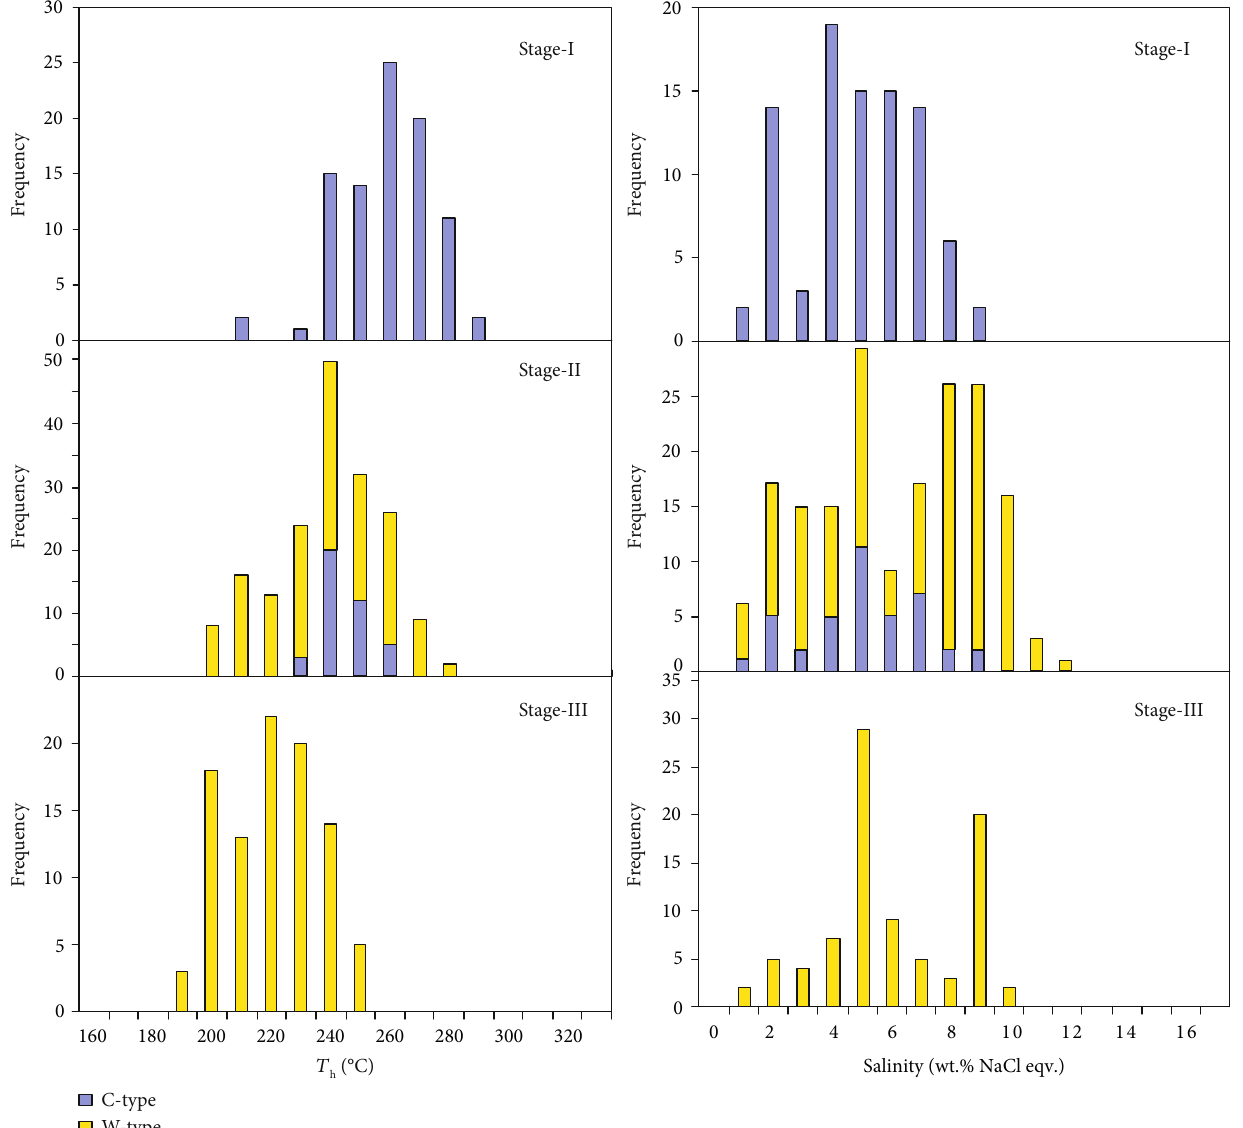
Figure 6: Histograms of total homogenization temperatures ( T